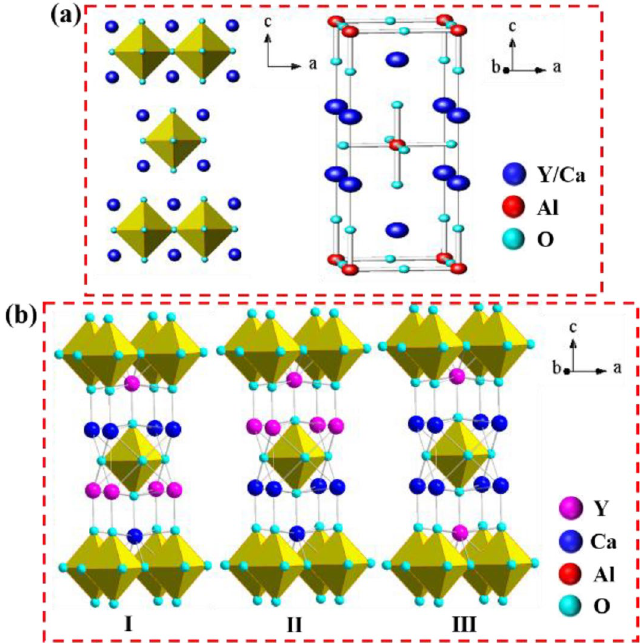
Figure 1. ( a ) The crystal structure model and ( b ) three nonequivalent configurations of the CYA unit cell (denoted as “I”, “II” and